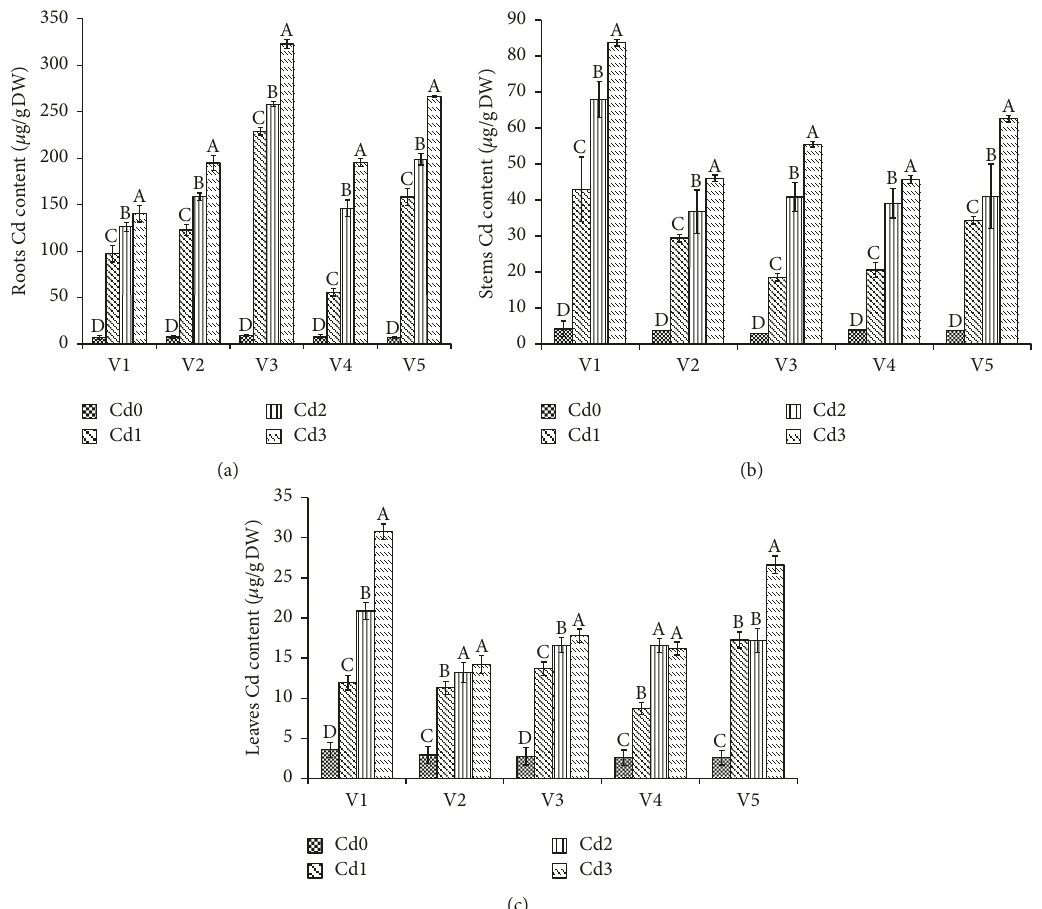
Figure 1: Cd uptake in (a) roots, (b) stems, and (c) leaves of the five different rice cultivars under induced Cd stress at panicle heading stage. The values are representative of three replicated means per treatment ± SE. Different letters indicate significant differences between treatments at 𝑃 ≤ 0.05 ,